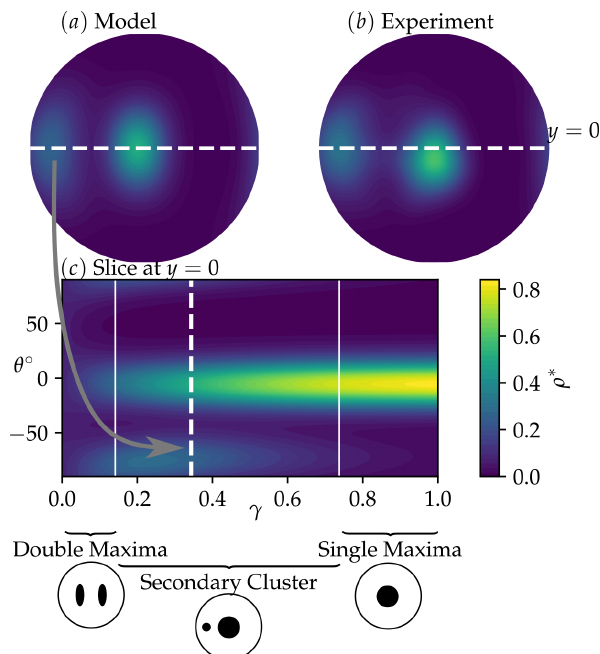
Figure 7. To illustrate the fabric we show a simulation in simple shear at T = − 5 ◦ C. Panel (a) shows a pole figure from the model at an effective strain of γ = 0 . 345 (where the strain rate is defined as in Eq. 9). Panel (b) shows a pole figure from laboratory exper- iments (Qi et al., 2019) at the same temperature and strain, show- ing good agreement. More comparisons like this can be found in Richards et al. (2021). The white dotted line in (a) and (b) shows y = 0. Panel (c) shows f ∗ at y = 0 against strain. Here the white dotted line highlights the strain at which the pole figure is plotted. θ is the polar angle. The grey arrow shows the secondary cluster transposed from the pole figure to the γ − θ diagram. Also high- lighted is the classification of the different fabric types at different strains, from double maximum to secondary cluster to the steady- state single maximum. For this figure only the principal strain axes are oriented at θ = ± 45 ◦